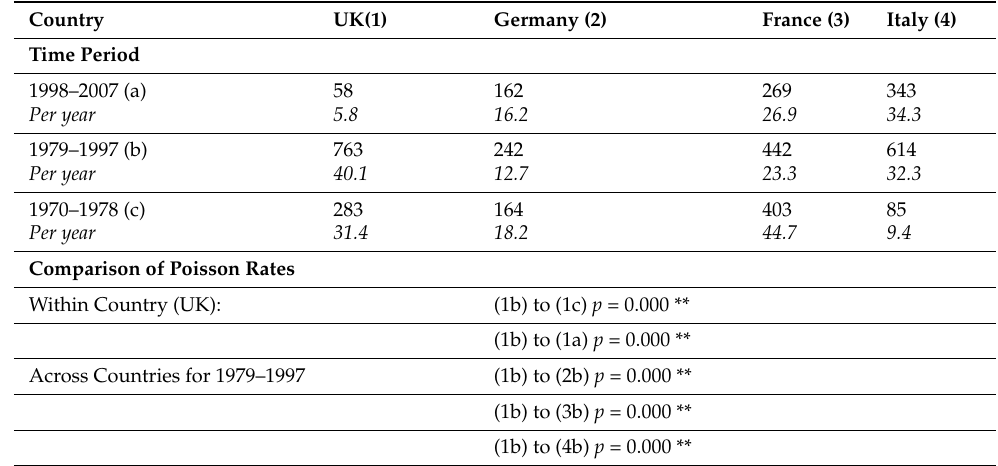
Table 4. Total and per Year Number of Fatalities from Multi-fatality Disasters (Excluding Air Acci- dents),